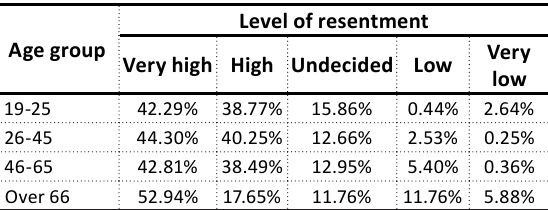
Table 4. Level of resentment towards dual quality structured by